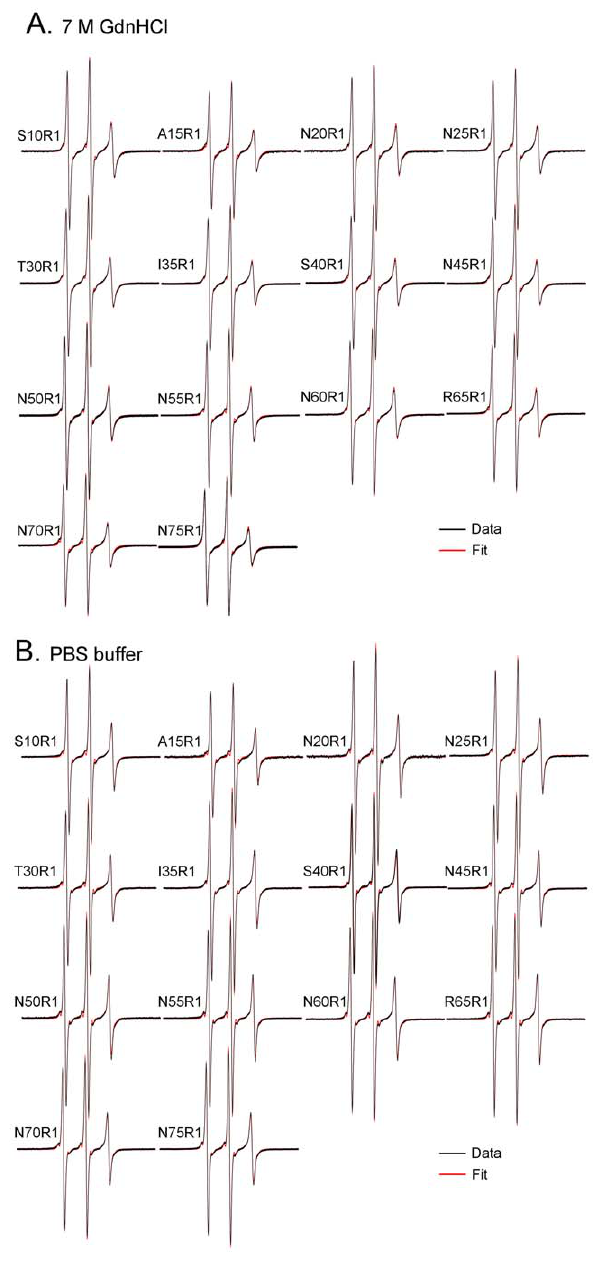
Figure 2. EPR spectra of spin-labeled Ure2p 1–89 -M tethered on solid support. (A) EPR spectra in 7 M GdnHCl. (B) EPR spectra in PBS. Experimental spectra are shown in black and best non-linear least squares fits are shown in red. All spectra were simulated well with one spectral component, suggesting a single structural state at all labeled sites.